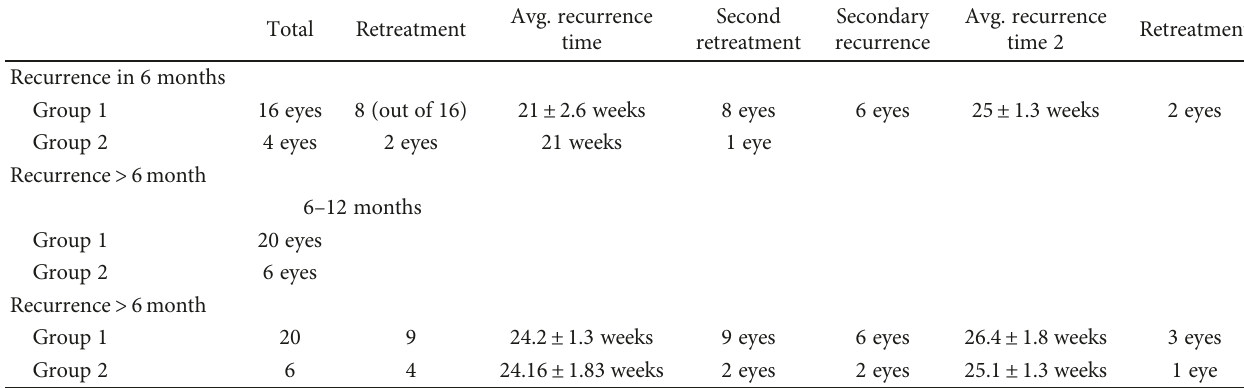
Table 3: Recurrence and retreatment number and